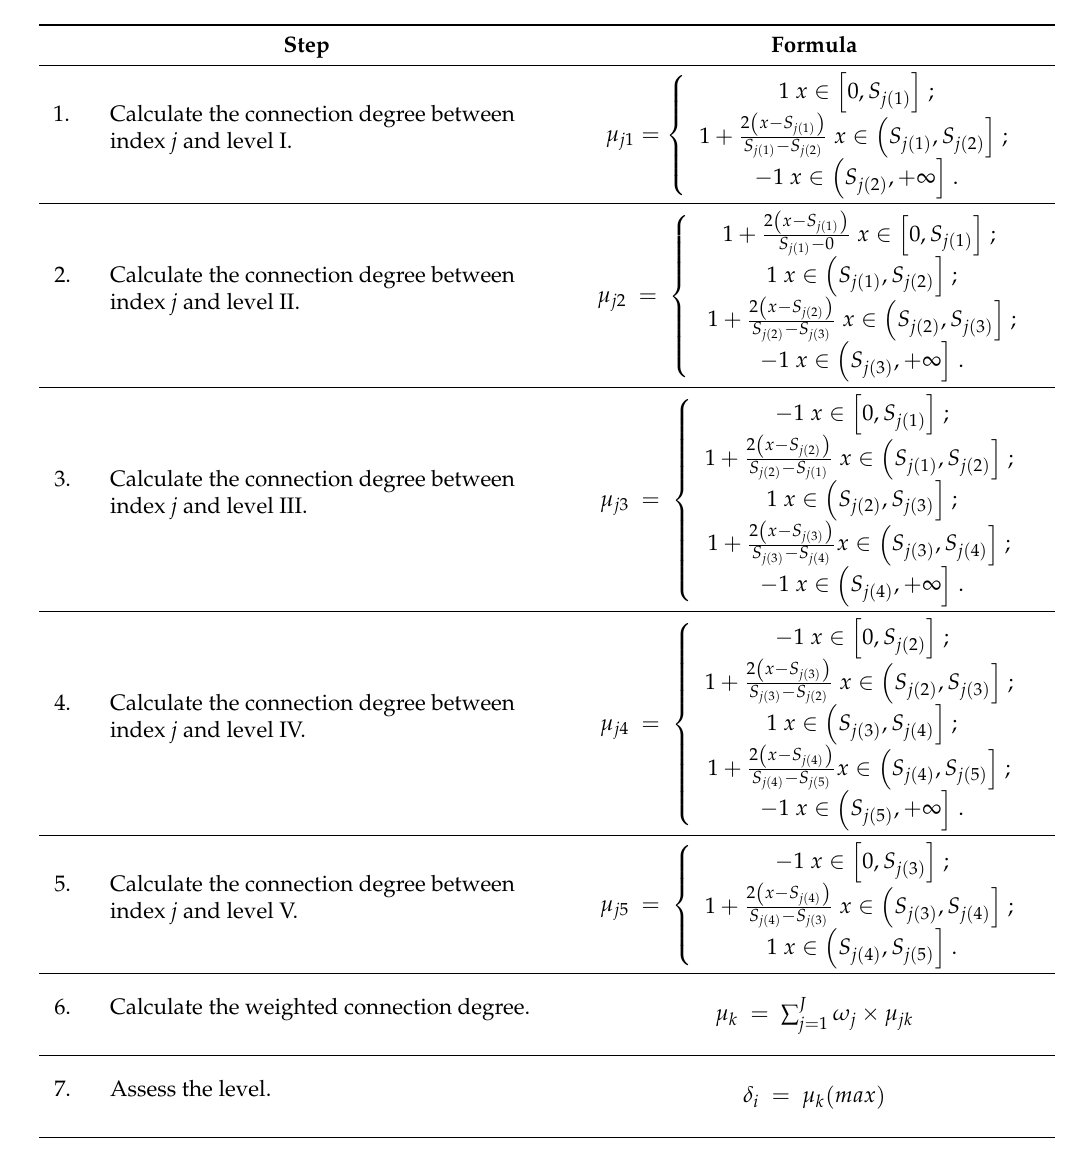
Table A3. The step and formula of